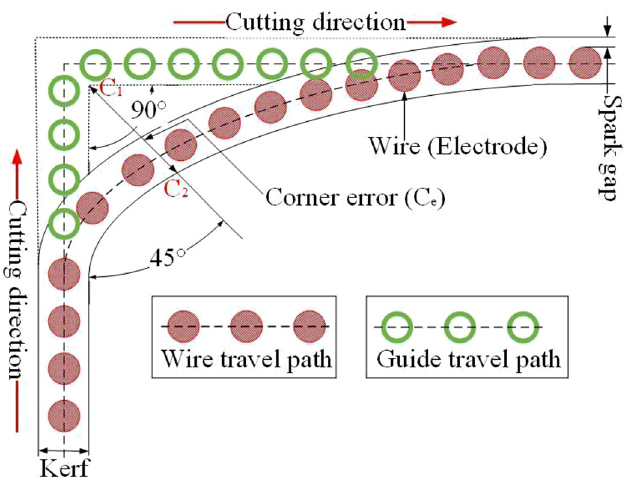
Fig. 2. Schematic representation of corner pro fi